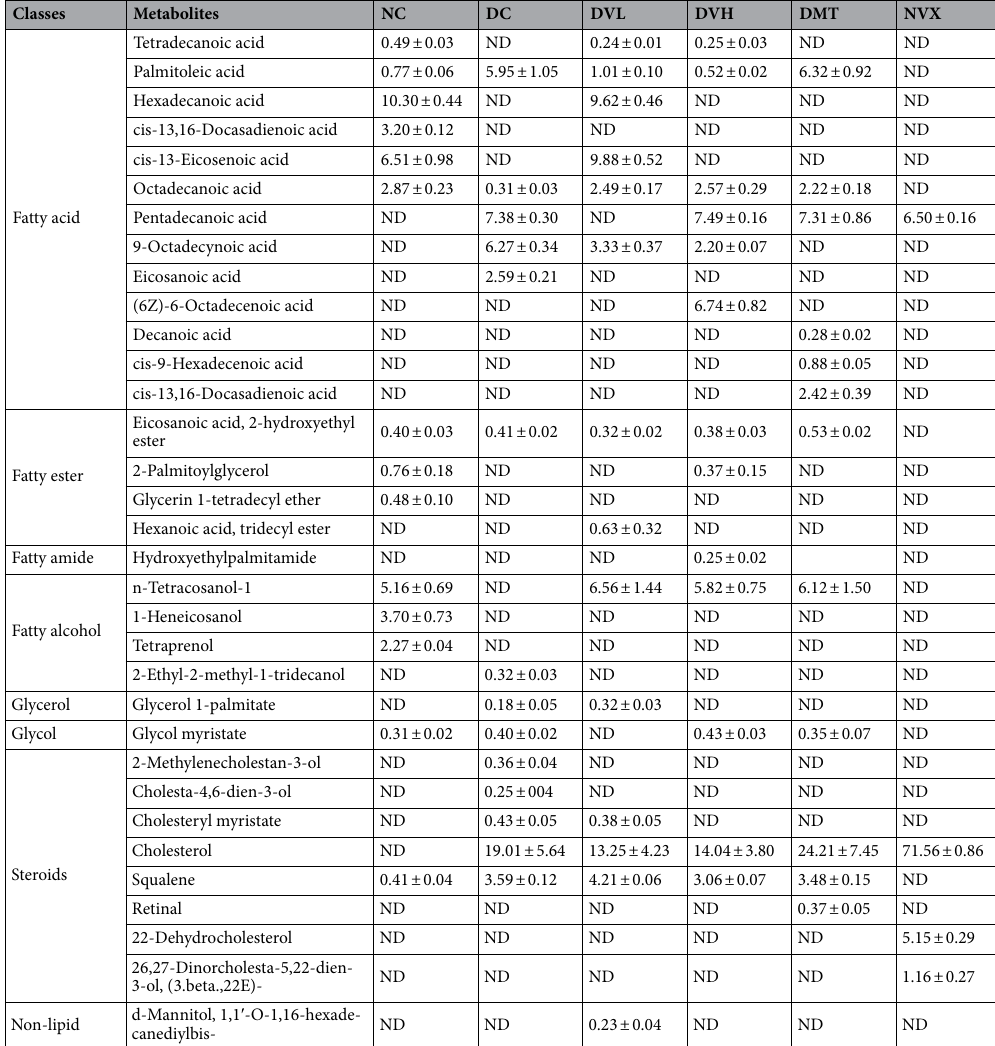
Table 1. GC–MS identified lipid metabolites in muscle tissues of experimental groups. Values = mean ± SD; n = 5. NC = normal rats, DC = Diabetic control, DVL = diabetic rats + vanillin (150 mg/kg b.w), DVH =